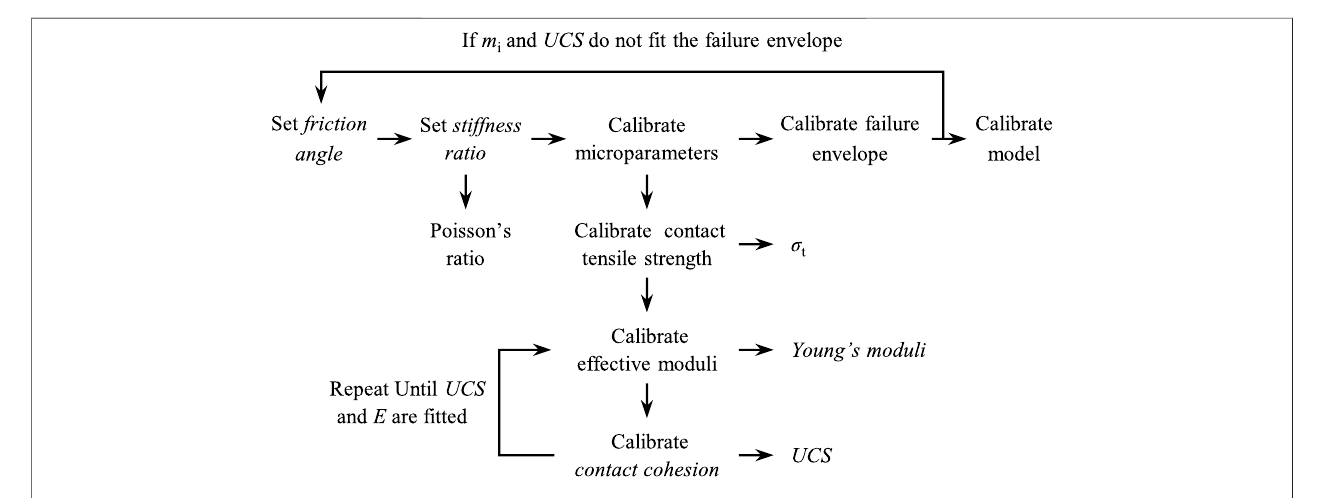
FIGURE 3 | Calibration procedure of microscopic parameters [30, 31].